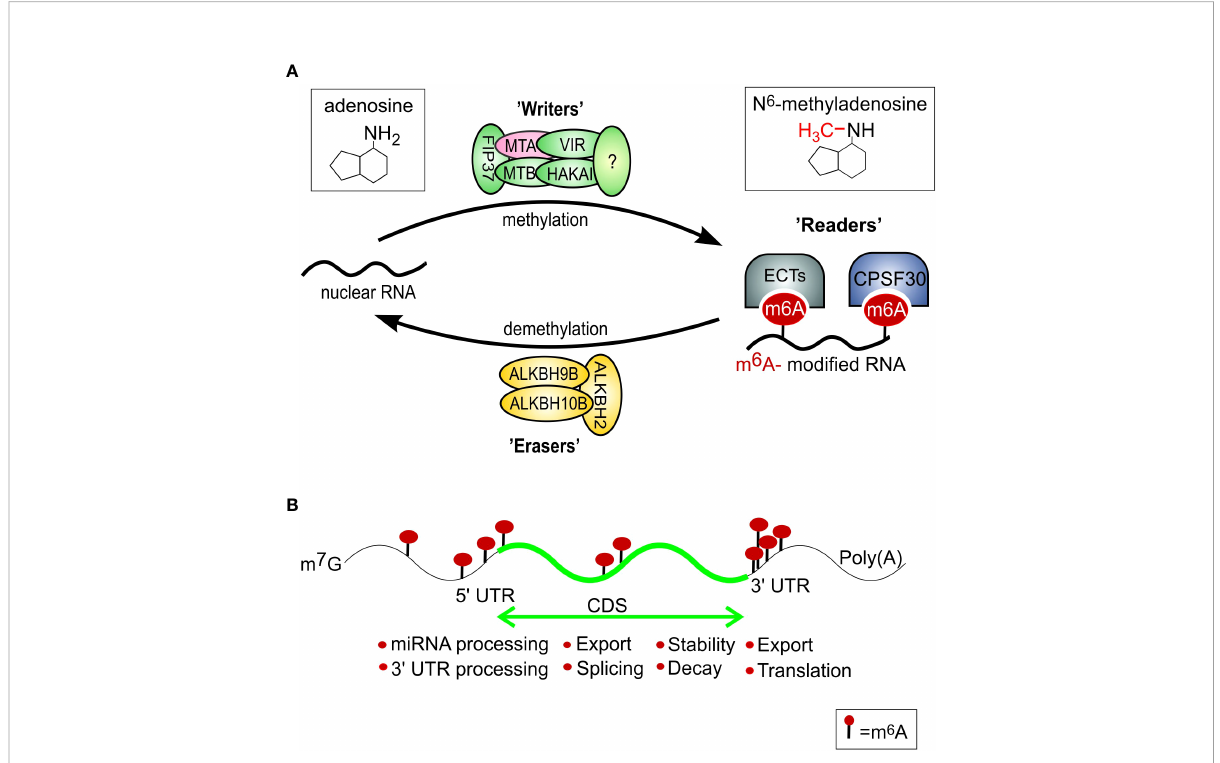
FIGURE 1 m 6 A mRNA modi fi cations. (A) Regulation of mRNA m 6 A modi fi cation in plants through the action of a network of m 6 A writers (methyltransferase), erasers (demethylase), and reader proteins. The m 6 A writer complex consists of the proteins MTA, MTB, FIP37, VIRILIZER, and HAKAI. The m 6 A modi fi cations can be removed by ALKBH2, ALKBH9B, and ALKBH10B proteins within the nucleus. The ECT2/3/4 and CPSF30 proteins serve as m 6 A readers that bind speci fi cally to m 6 A sites and mediate distinct functions. The expression of subunit MTA (pink) was shown to be upregulated during DILS previously (Sobieszczuk- Nowicka et al., 2018). (B) Typical m 6 A distribution in regions of an mRNA and its readout affects mRNA fates, including traf fi cking, stability, decay, translation, and localization. Based on: Zheng et al., 2020; Sokpor et al., 2021; modi fi